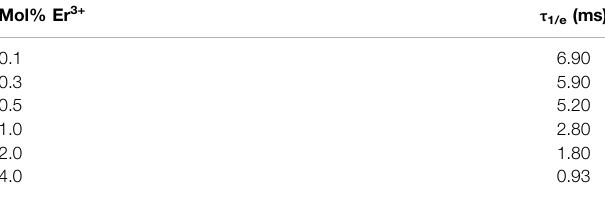
Mol% Er 3+ τ 1/e (ms)